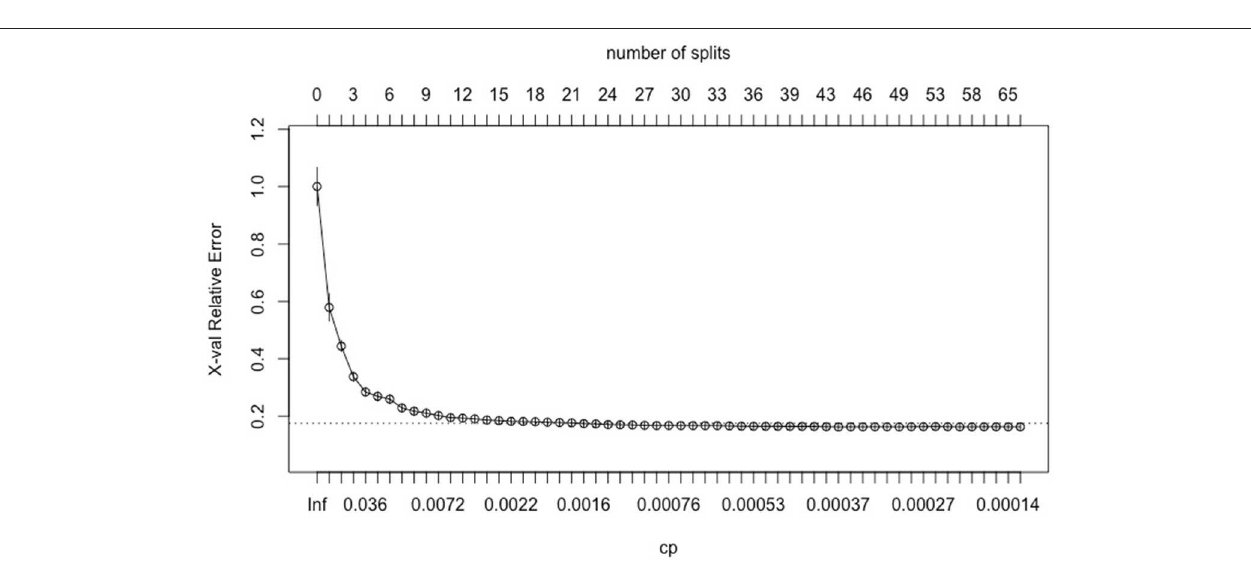
Frontiers in Education |